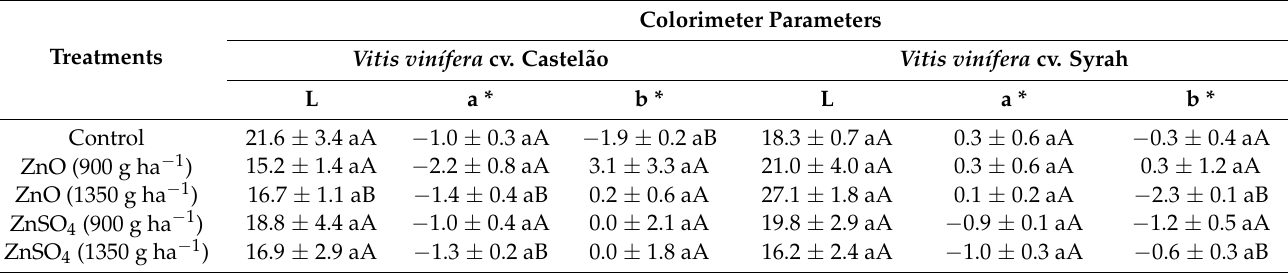
Table 5. Average ± S.E ( n = 3) of colorimeter parameters of the skin of grapes of Vitis vinifera, varieties Castel ã o and Syrah. Letter a indicates the absence of significant differences among treatments in each variety, whereas letters A and B indicate the significant differences between each parameter for both varieties in each treatment (statistical analysis using the two-way ANOVA test, p < 0.05). The L* parameter represents the brightness of the sample, with a range between 0 (black) and 100 (white). The parameters a* and b* indicate color variations between red (+60) and green ( − 60), and between yellow (+60) and blue ( − 60),